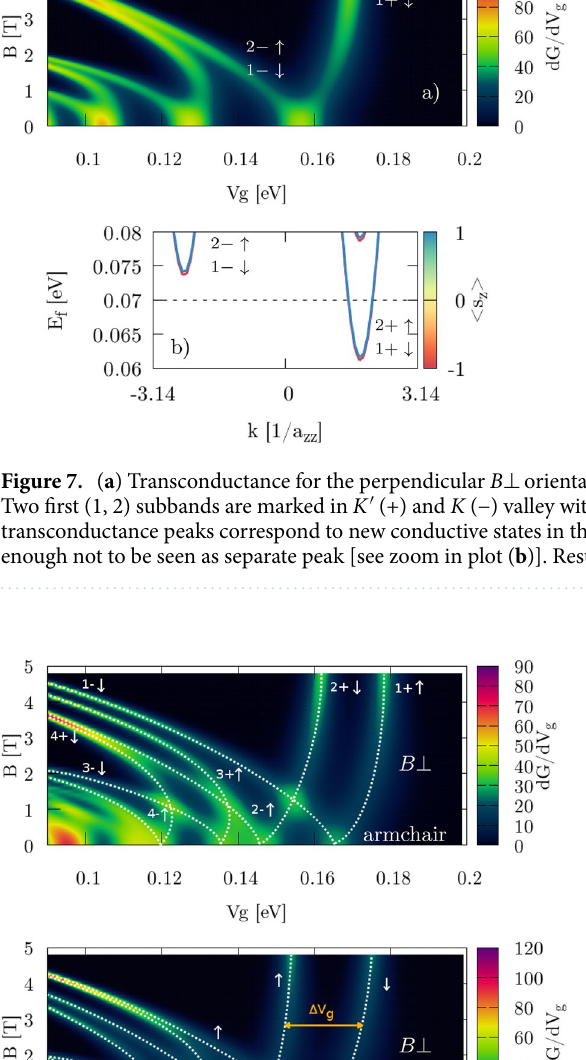
0, 0, B Figure 8. Transconductance for perpendicular B z ] orientation of external magnetic field applied to = [ the system with active SO (nonzero terms in Hamiltonian). Numbers denote the subband index in K ′ valley (+) and K (−) with spin ( ) marked by white dotted lines. The (cid:31) V g term is calculated between two spin-correlated ↑ ↓ subbands within the same valley